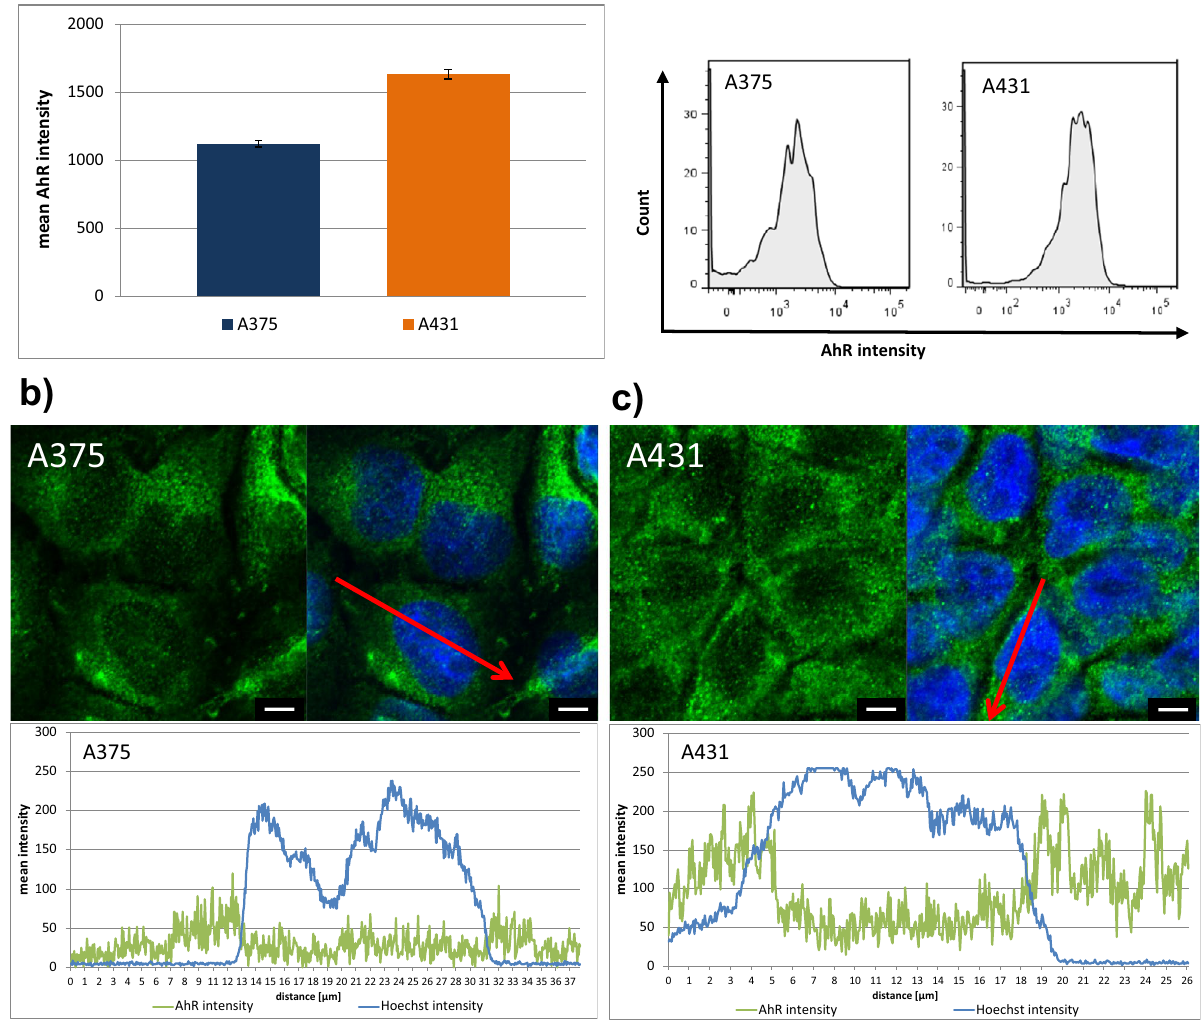
Figure 6. ( a ) Quantification of protein level of the AhR and exemplary histograms demonstrated a tendency to a higher overall expression of AhR in squamous cell carcinoma (A431) cells (NC3000, mean ± SD). Fluorescence images of A375 ( b ) and A431 cells ( c ) showed the localisation of the AhR (green) mostly in the cytosol, with a small fraction being detectable in the nucleus (blue; bar 5 µm). The intensity profile determined along the red arrow is shown underneath the microscopic image. Note the higher basal level of AhR intensity in A431 cells. (confocal microscopy: LSM